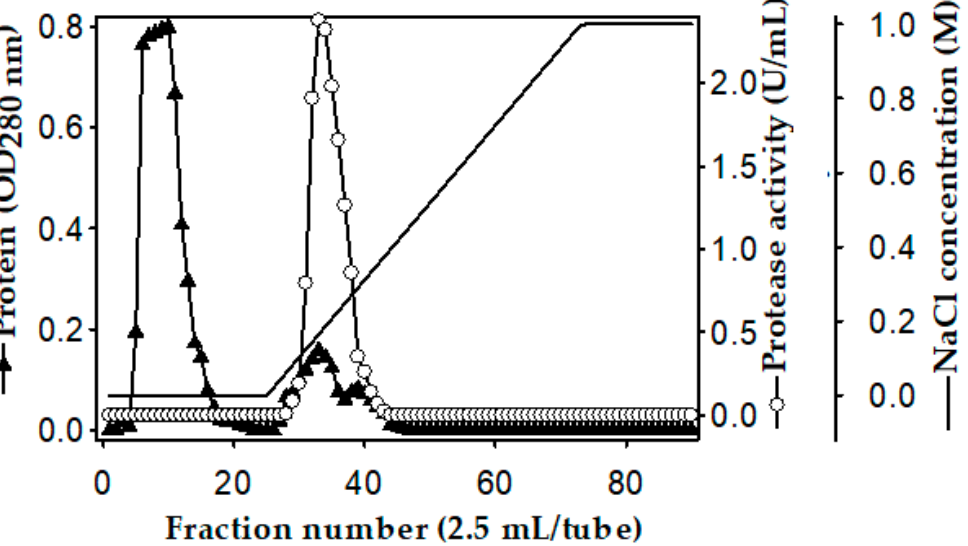
Table 1. Purification characteristics of the protease from P. mucilaginosus TKU032.